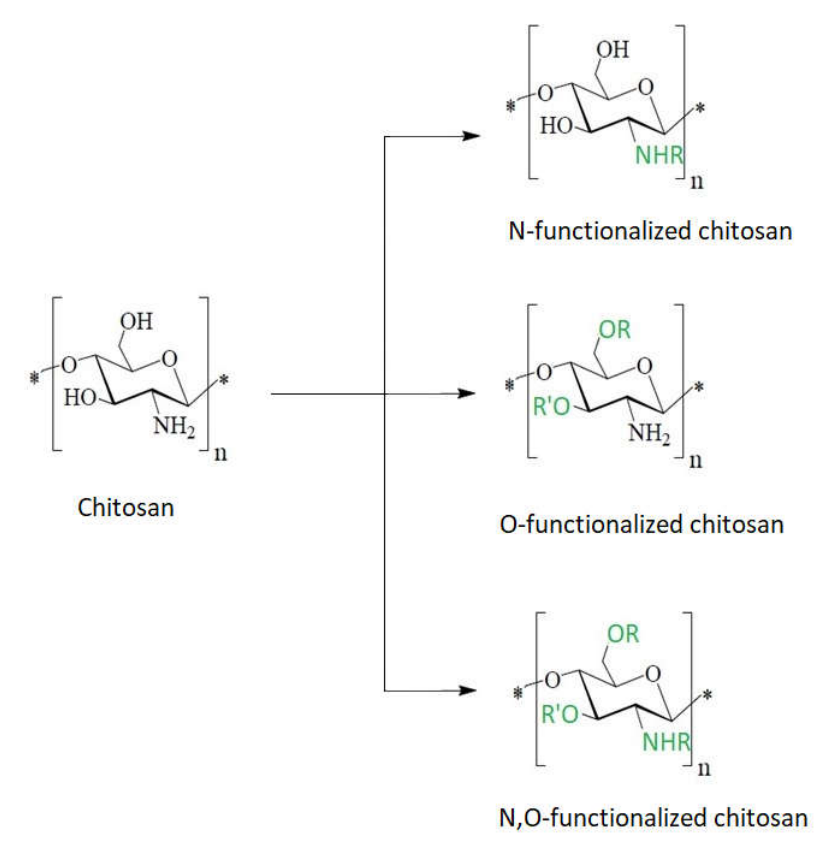
Figure 8. Schematic chitosan functionalization.